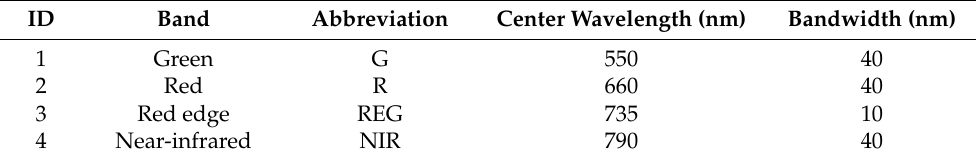
Figure 1. Location of the study area. ( a ) Location of the Kenli District in China; ( b ) test area in the Kenli district; ( c ) UAV image covering the test area. Table 1. Band information of multispectral camera